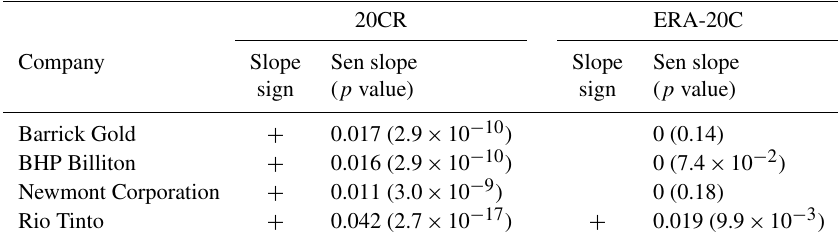
Table B1. Mann–Kendall test results for the count of the number of extreme 30-day extreme rainfall event with a 10-year return level on four mine portfolios, using both the NOAA and ECMWF climate datasets (computations performed for the period 1851–2014 for the 20CR data and 1900–2010 for ERA-20C).